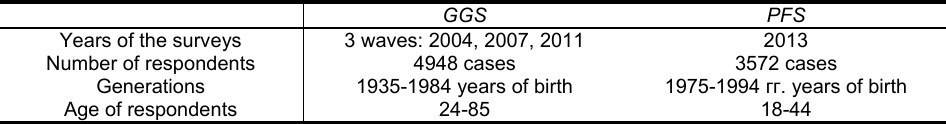
Table 1. The GGS and PFS databases